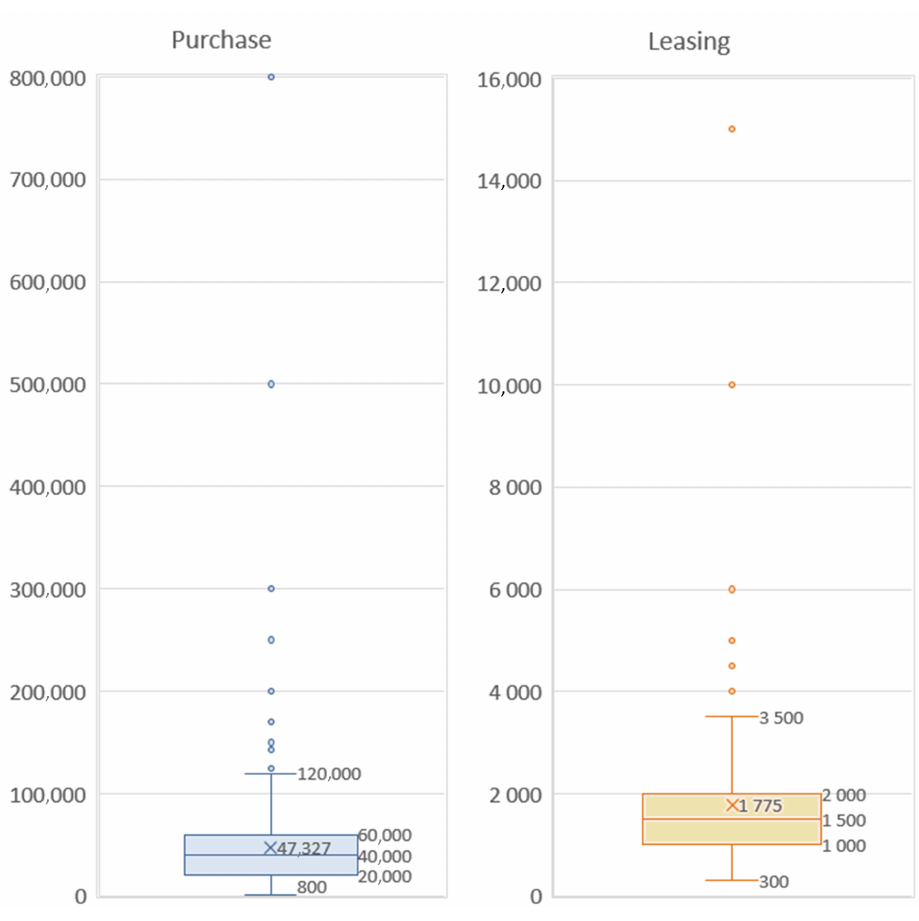
Figure 4. Frequencies of the willingness to pay (in